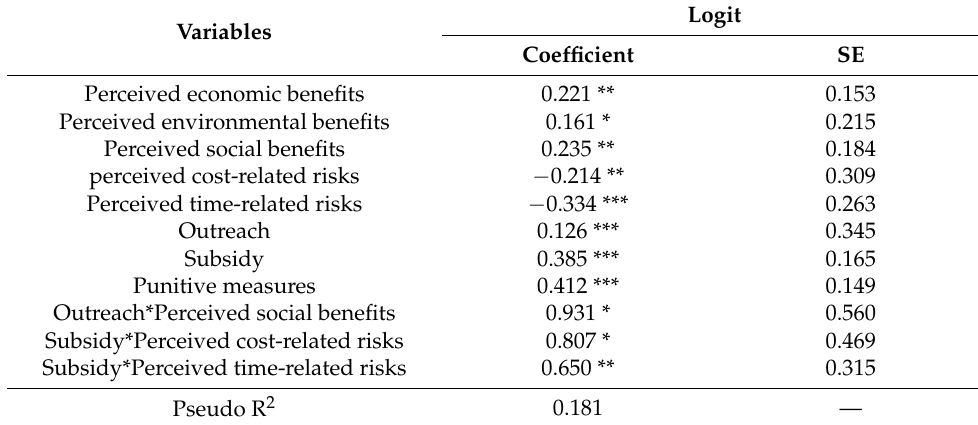
Table 4. The effect of interaction terms on